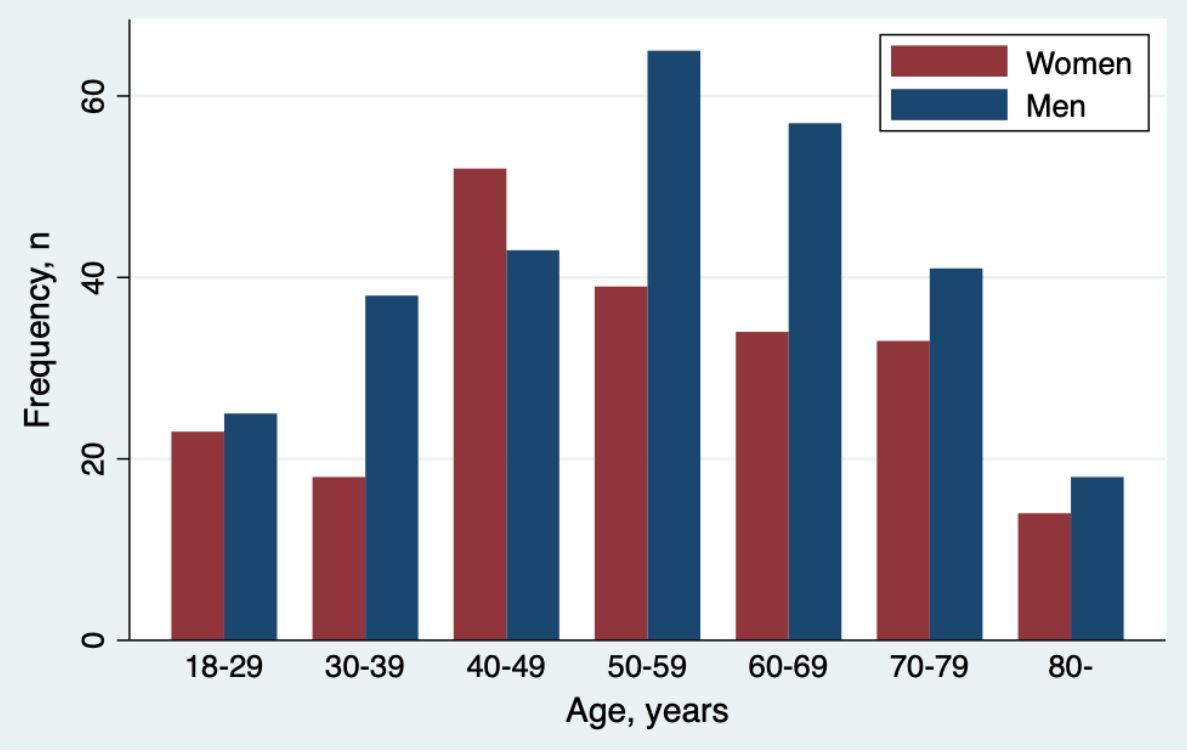
Figure 2. Age and sex distribution of the study population (n=500). Total number of patients in each age group—18-29: 48, 30-39: 56, 40-49: